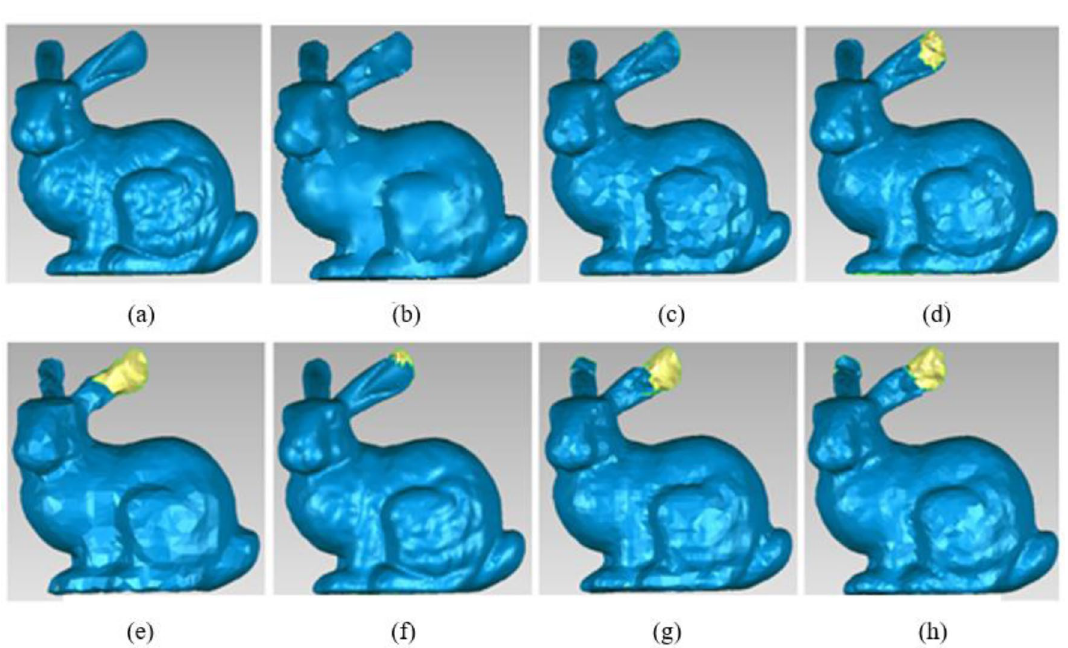
Figure 12. Different simplified results of Bubby. ( a ) Original data. ( b ) Our method. ( c ) The simplified method based on DFPSA. ( d ) The simplified method based on Gaussian spheres. ( e ) The simplified method based on octree coding. ( f ) The k-means clustering simplification method. ( g ) The uniform simplification method. ( h ) The geometric algebra